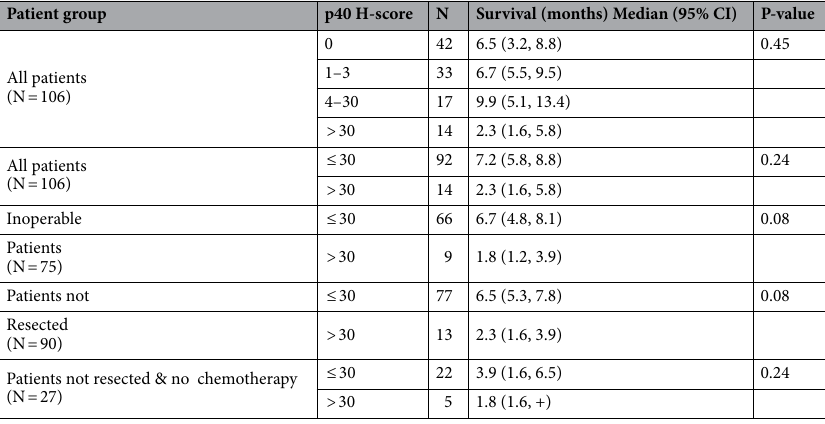
Patients not resected & no chemotherapy (N = Table 3. Patient survival by FNB p40 H-score.